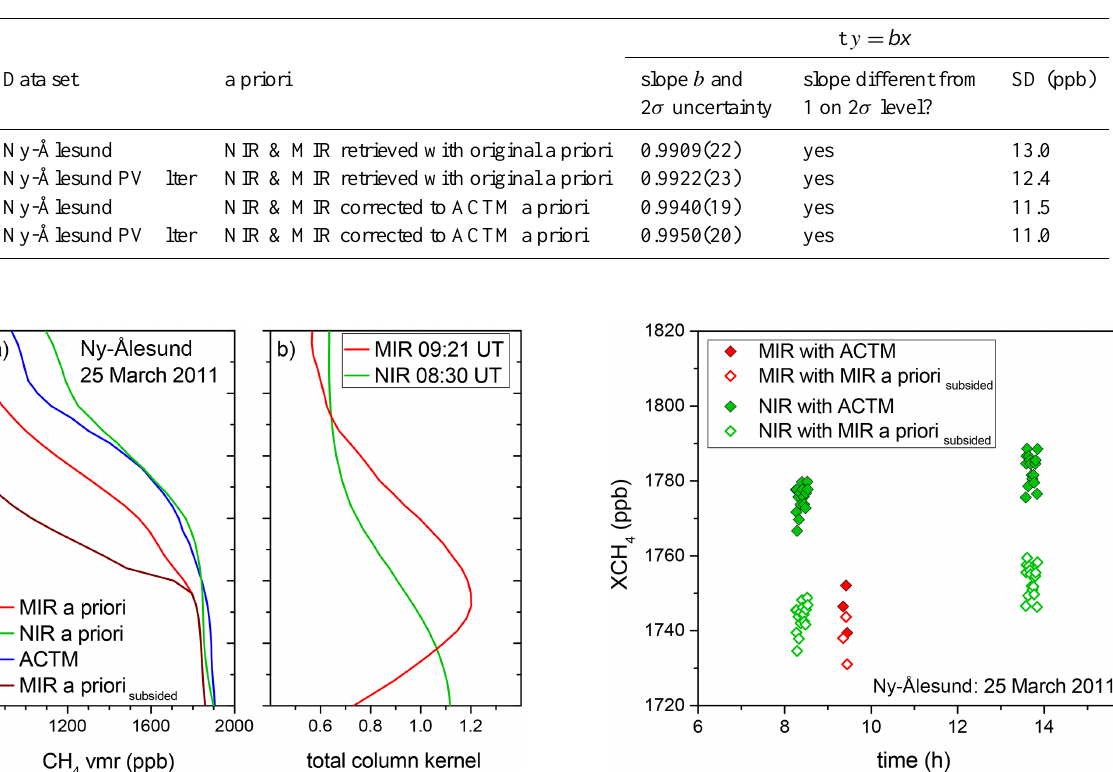
Table 3. As Table 2, but only for Ny-Ålesund. The data set “Ny-Ålesund PV filter” corresponds to MIR and NIR retrievals that are not influenced by the polar vortex.